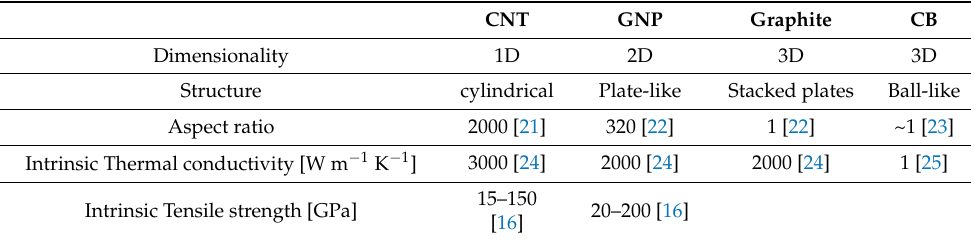
Table 1. Properties of carbon-based fillers: carbon nanotube (CNT), graphene nanoplatelets (GNP), graphite, and carbon black (CB).